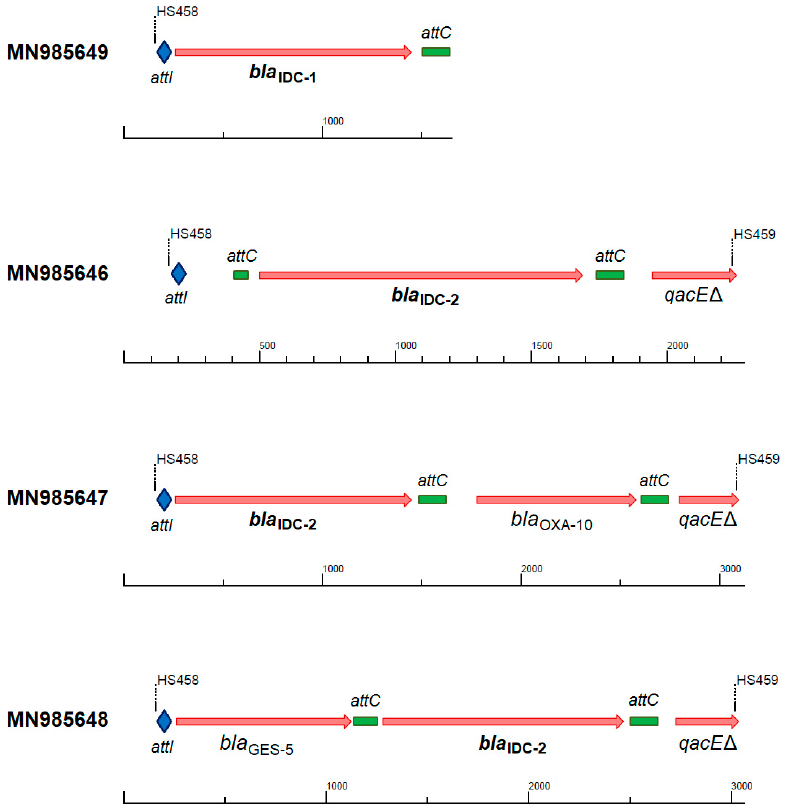
Figure 1. Genetic context and nucleotide accession numbers of the bla IDC gene cassettes recovered from the amplified functional metagenomics dataset of class 1 integrons (primer pair HS458-HS459) [48,56]. Attachment sites: attI marked as blue rhomb, attC marked as green rectangle; bla IDC-1 and bla IDC-2 : novel integron-derived c ephalosporinases; bla OXA-10 : class D β -lactamase OXA-10; bla GES-5 : class A β -lactamase GES-5 (carbapenemase); qacE ∆ : quarternary ammonium compound resistance protein (truncated).